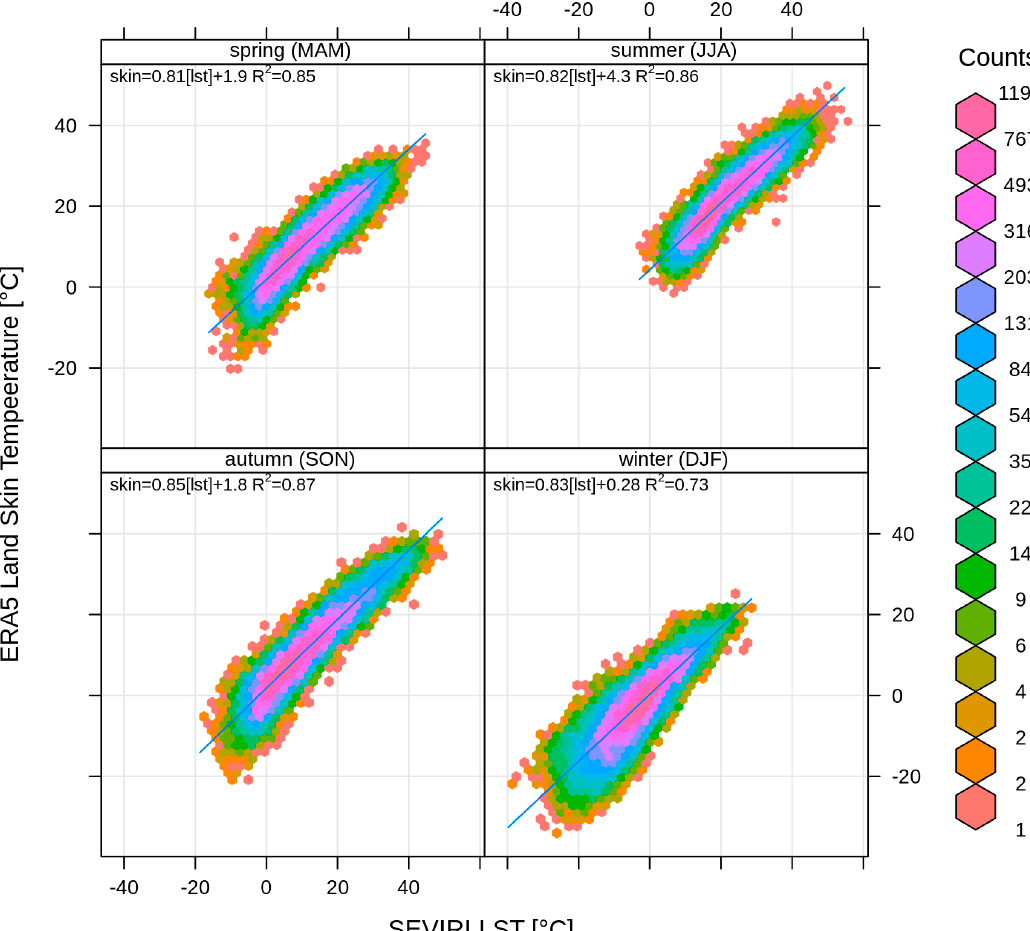
Figure 4. SEVIRI LST vs. ERA5ST (2016–2017), based on randomly selected pixels (300 / h). Blue lines shown on the plot are the best fit lines of the linear model between the two analyzed datasets. Table 1. Pearson’s correlation coefficients between SEVIRI LST and selected covariates: elevation Covariate DJF MAM JJA